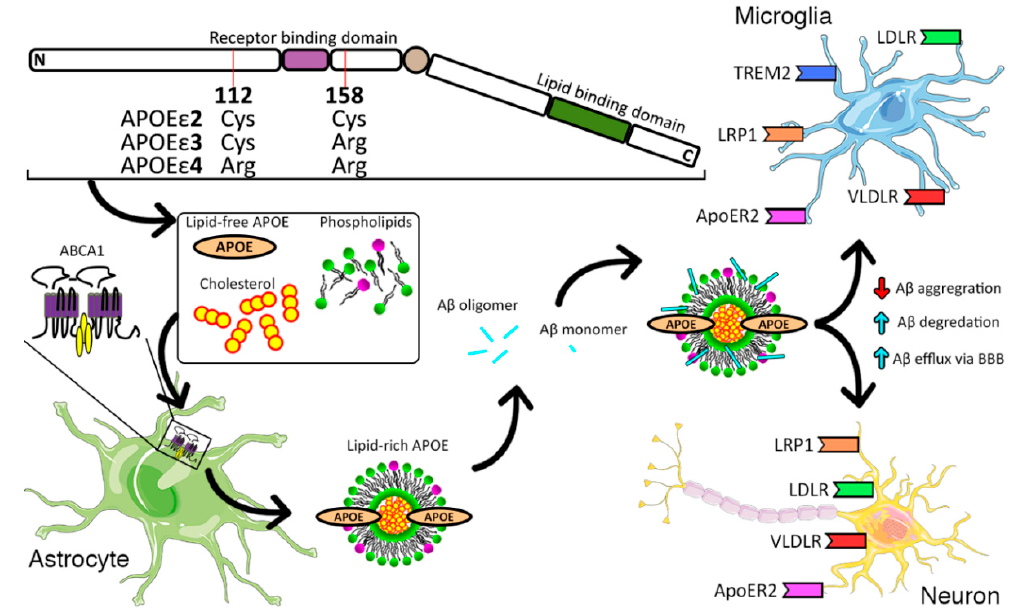
Figure 1. Role of Apolipoprotein E (APOE) in Alzheimer’s disease (AD). In humans, there are three APOE isoforms: APOE ε 2, APOE ε 3, and APOE ε 4. In the brain, APOE is secreted mainly by astrocytes and its lipidation is mediated by ABCA1. ABCA1 transports cholesterol and phospholipids to naïve APOE forming discoidal high-density lipid (HDL) particles. Lipid-rich APOE particles can interact with A β monomers and oligomers and bind to the low-density lipid (LDL) receptor family including LRP1, LDLR, VLDLR, and ApoER2 on both neurons and microglia, while also interacting with triggering receptor expressed on myeloid cells 2 (TREM2) only in microglia.